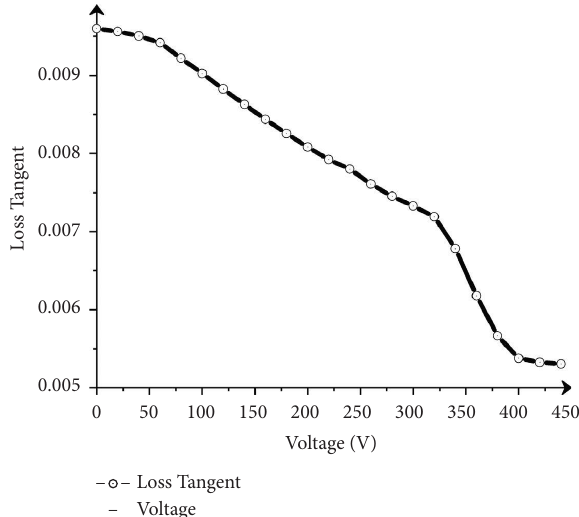
Figure 2: Te loss tangent of liquid crystal versus bias